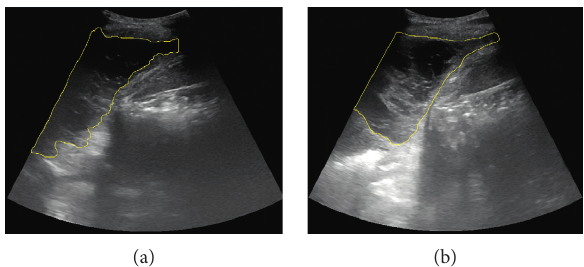
Figure 1: Image cropping technique for analysis using the Image J software. Using the freehand selection, we determine the area of interest. By applying histogram analyses, tissue echo levels are automatically calibrated to the value of 255 for the white pixels and 0 for the black pixels. The mean number of pixels in the selected area is automatically calculated.